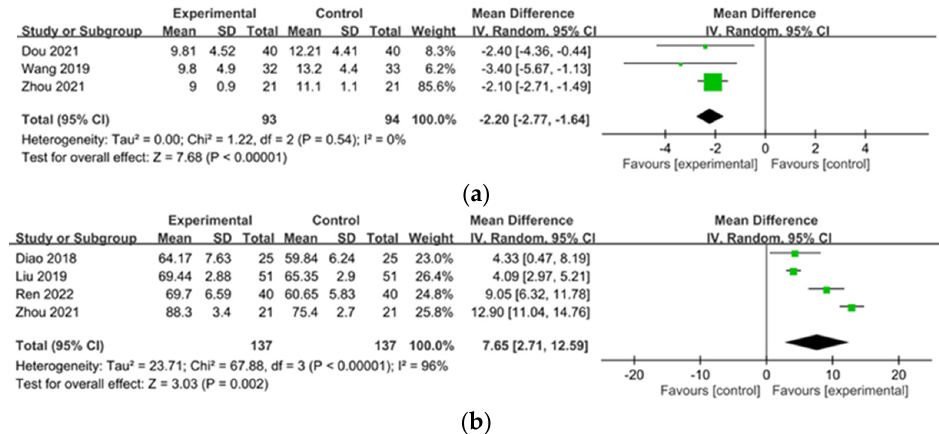
Figure 6. Forest plot of quality of life: ( a ) Pittsburgh Sleep Quality Index (PSQI); ( b ) Quality of Life (QOL) scale in patients with uremic pruritus treated with Chinese herbal medicine.